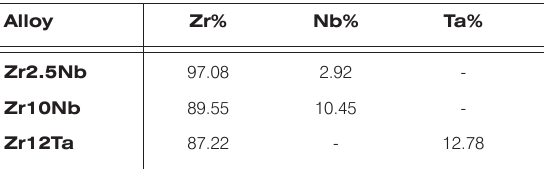
Table 1. Alloys composition according XRF.